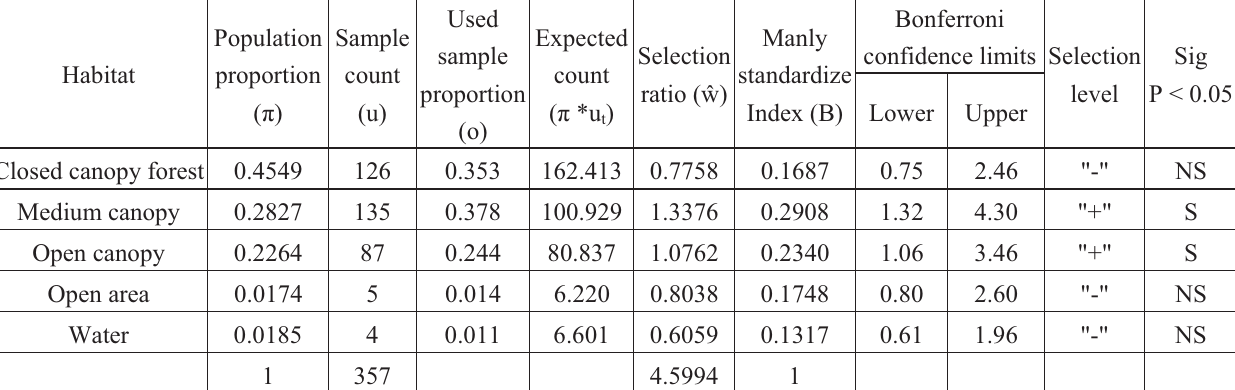
Table 2. Resource selection indices with Bonferroni confidence intervals for habitats used by an adult female elephant radio-monitored from August 25, 2007–May 14, 2008, near the Seblat Elephant Conservation Center, Bengkulu Province, Sumatra.